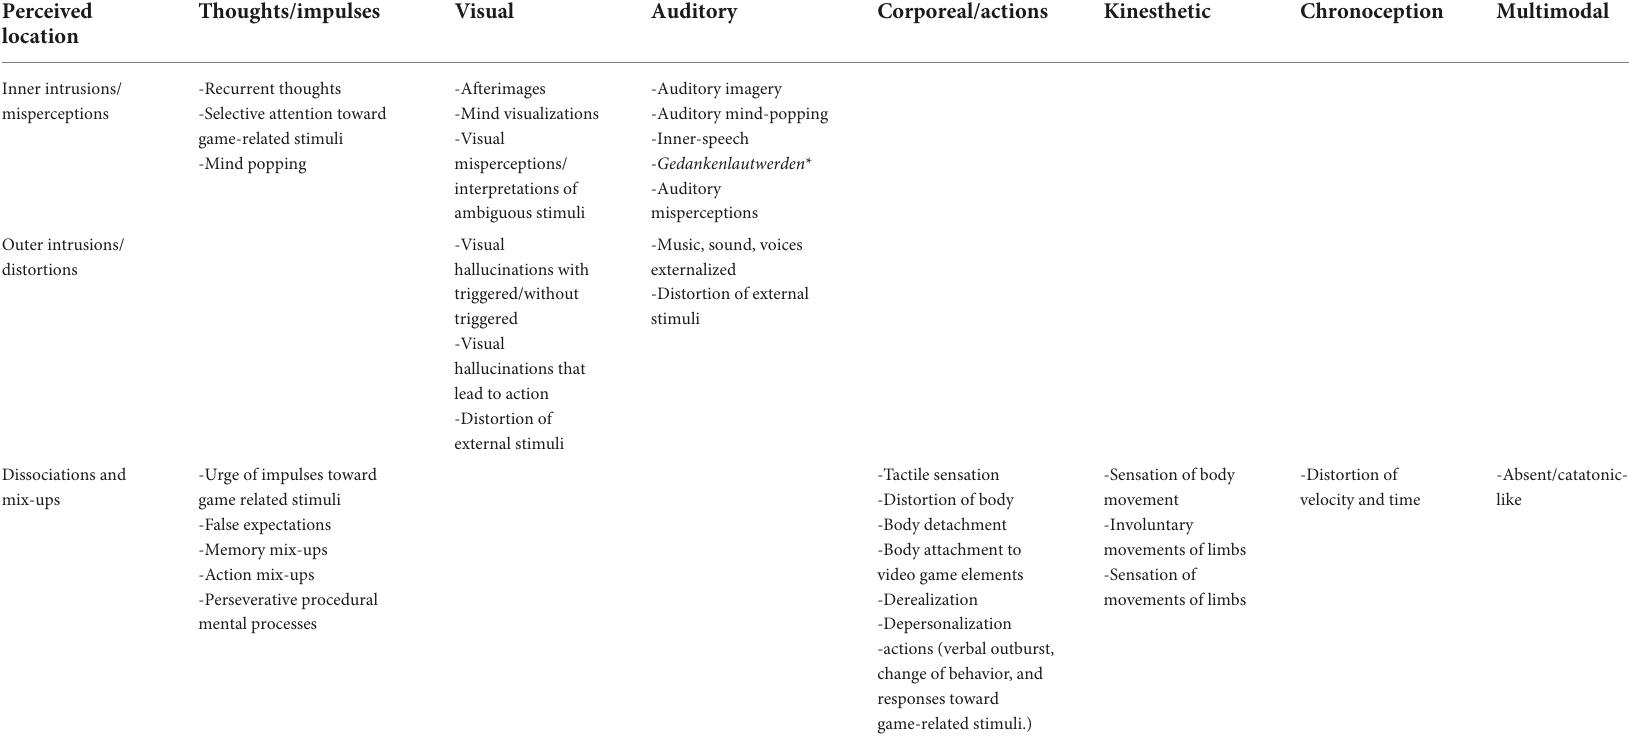
TABLE 2 Classification of GTP according to perceived location, type of phenomena and the sensory